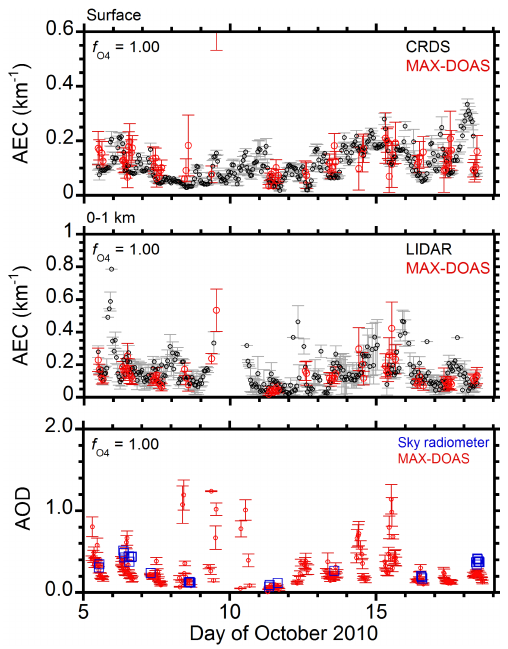
Figure 6. Same as Fig. 4, but a f O DOAS